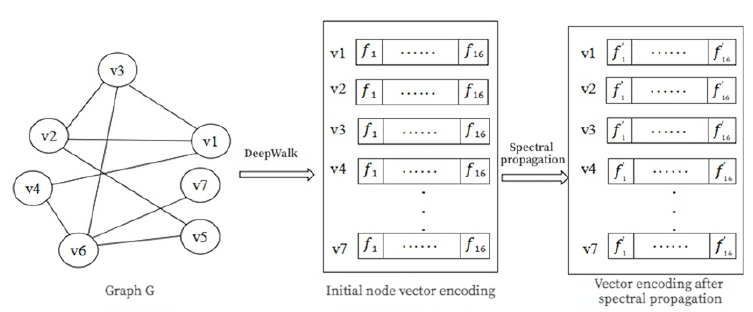
Figure 1. Node vector encoding acquisition